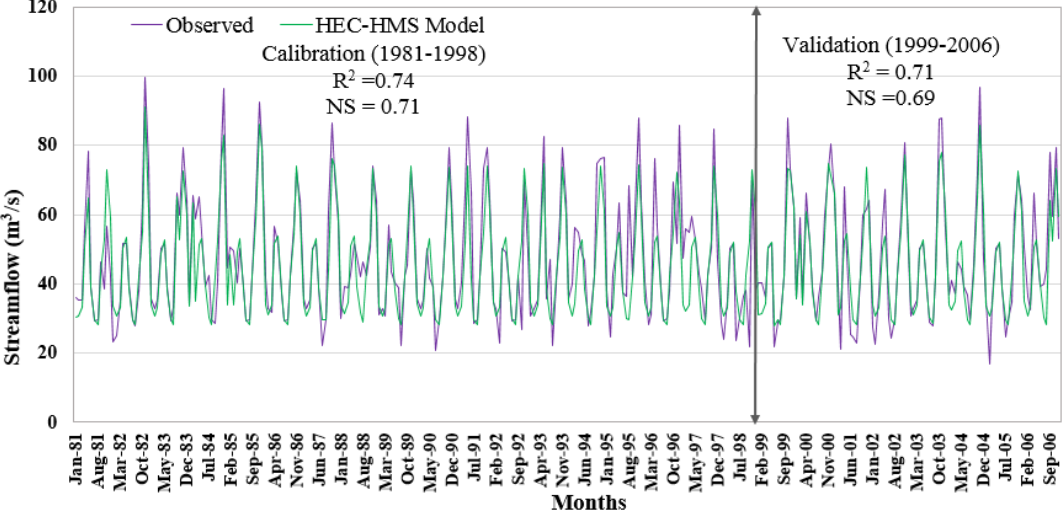
Figure 6. Simulated and observed monthly discharge for Bernam river basin during calibration and validation periods.